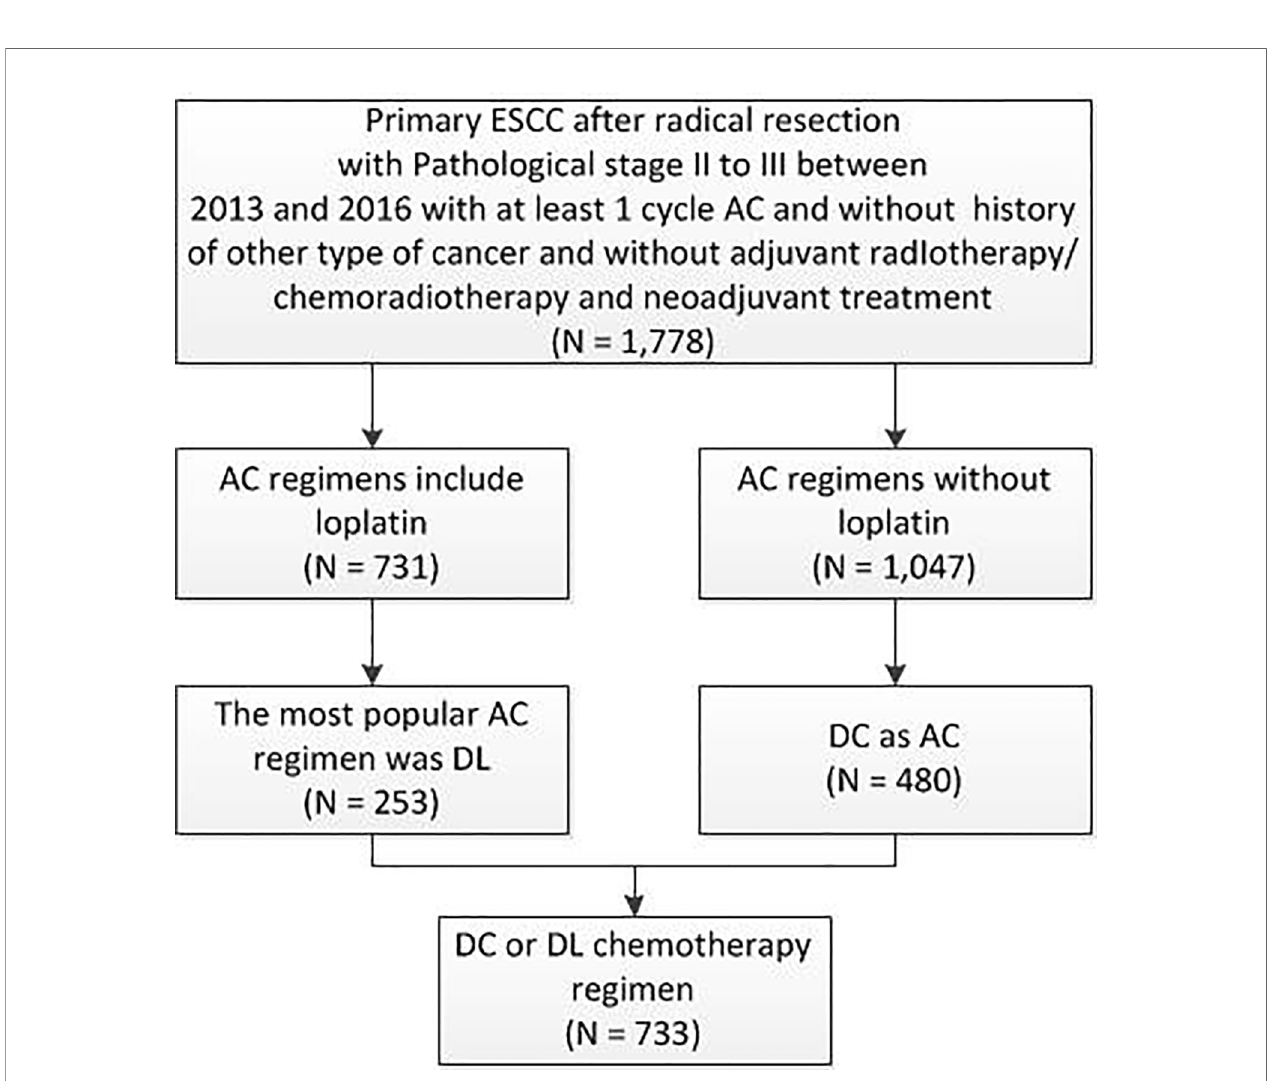
FIGURE 1 | Patient distribution diagram. ESCC, oesophageal squamous cell carcinoma; AC, adjuvant chemotherapy; DL, docetaxel+ lobaplatin; DC, docetaxel+ cisplatin; N,